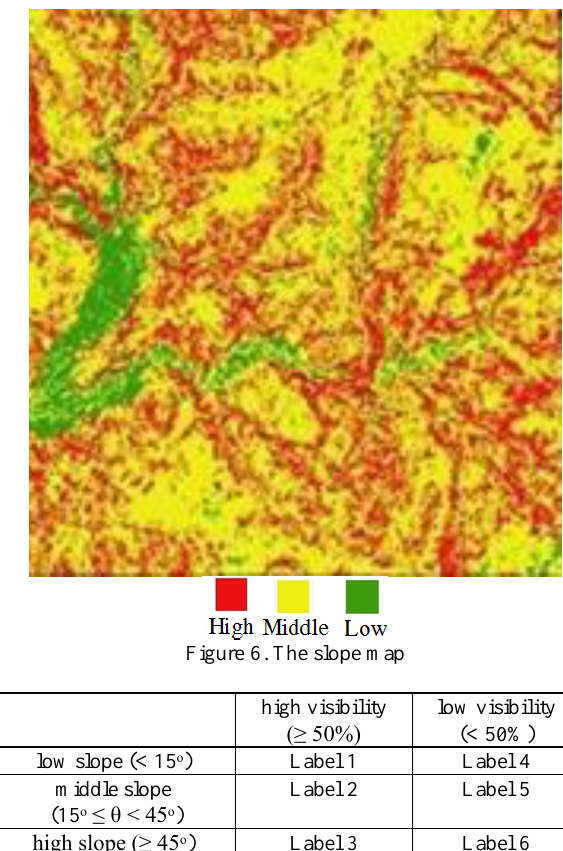
Figure 7. The classification